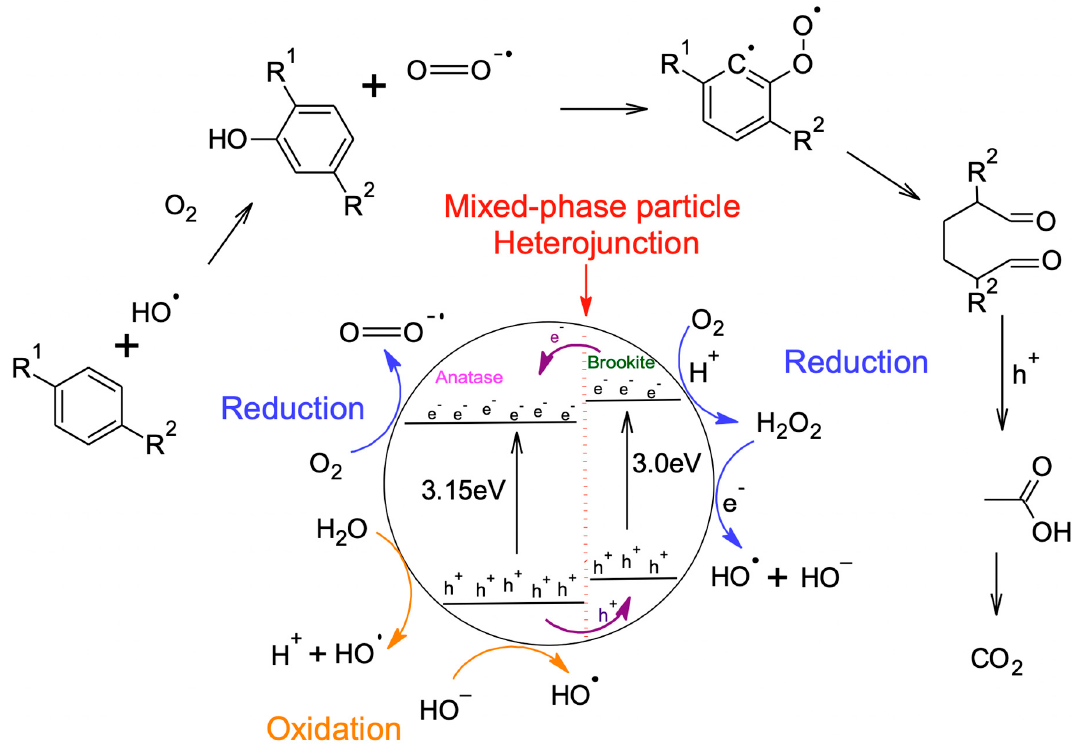
Schematic 1 Simplified mechanistic representation of the photocatalytic degradation of methyl orange on a mixed-phase A /b TiO 2 nanoparticle under UV illumination. Note for clarity the adsorption of MO is not